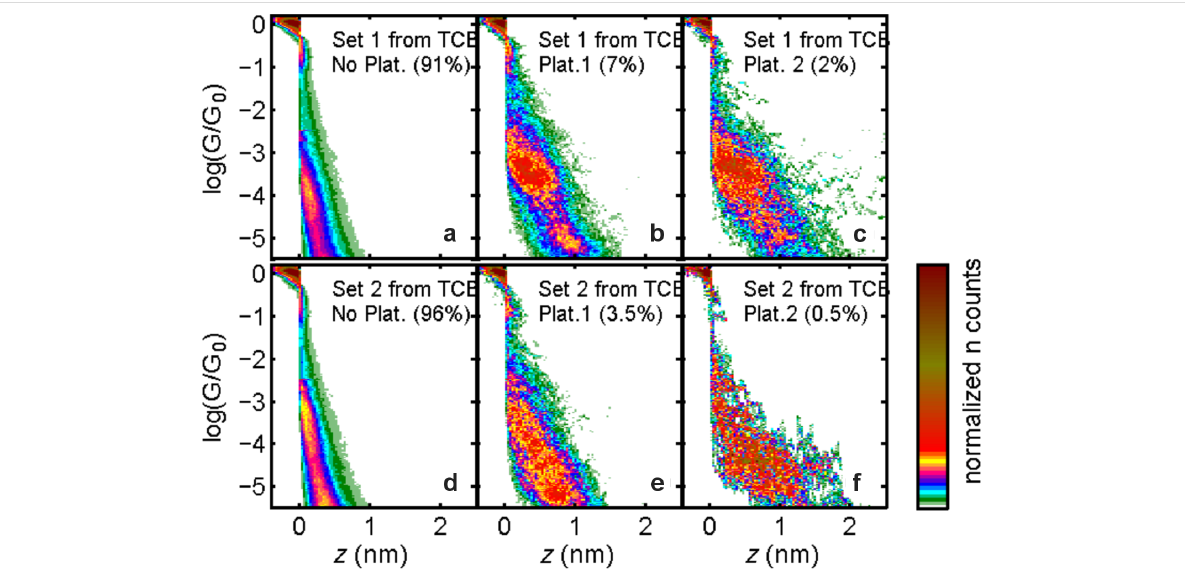
Figure 4: 2D histograms corresponding to compound 5 after exposing a gold substrate to the solution of the compound in TCB. For each measure- ment, the traces were separated into 3 groups: traces with no plateau (No Plat.), traces with poorly defined plateaus (Plat. 1), and traces with well- defined plateaus (Plat. 2). See text for details on the separation process. The percentage of traces included in each group is indicated in the brackets.